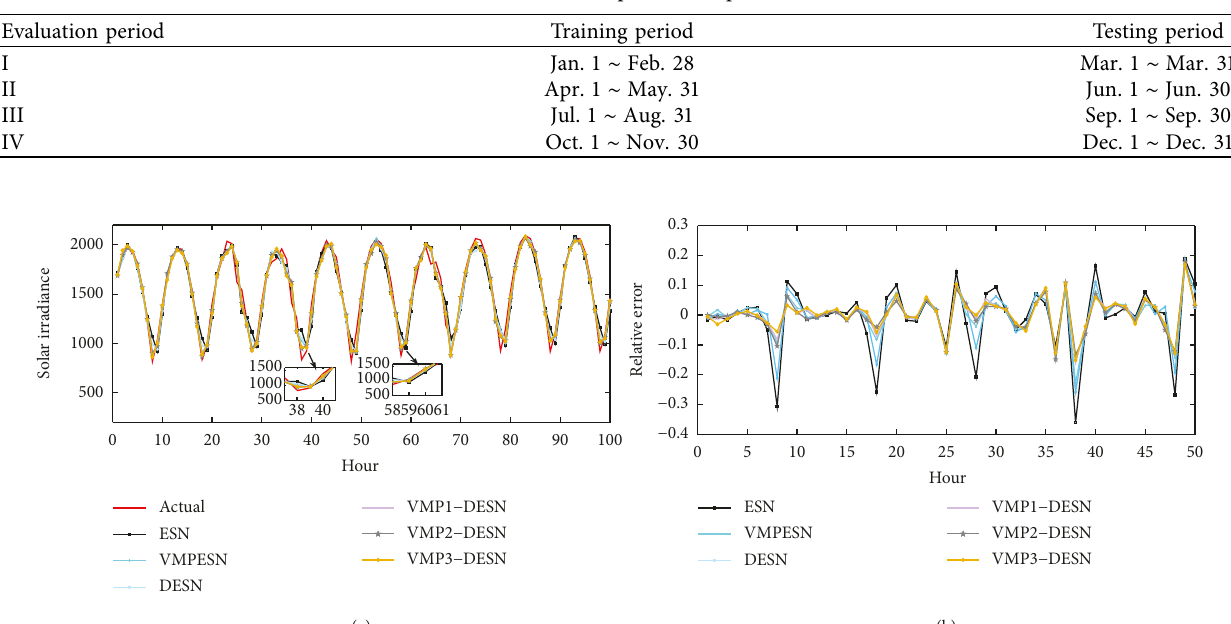
Table 2: Different evaluation periods for prediction models.